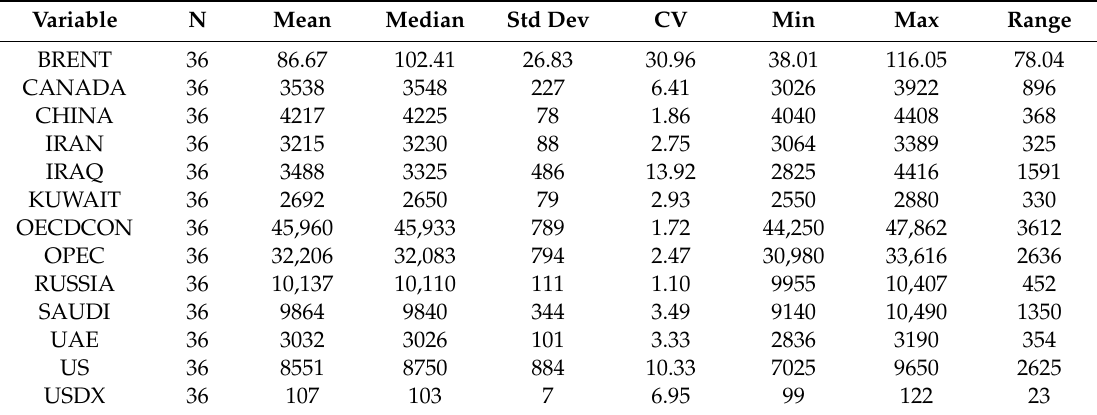
Table 15. Panel 6 period (2013–2015): summary statistics.